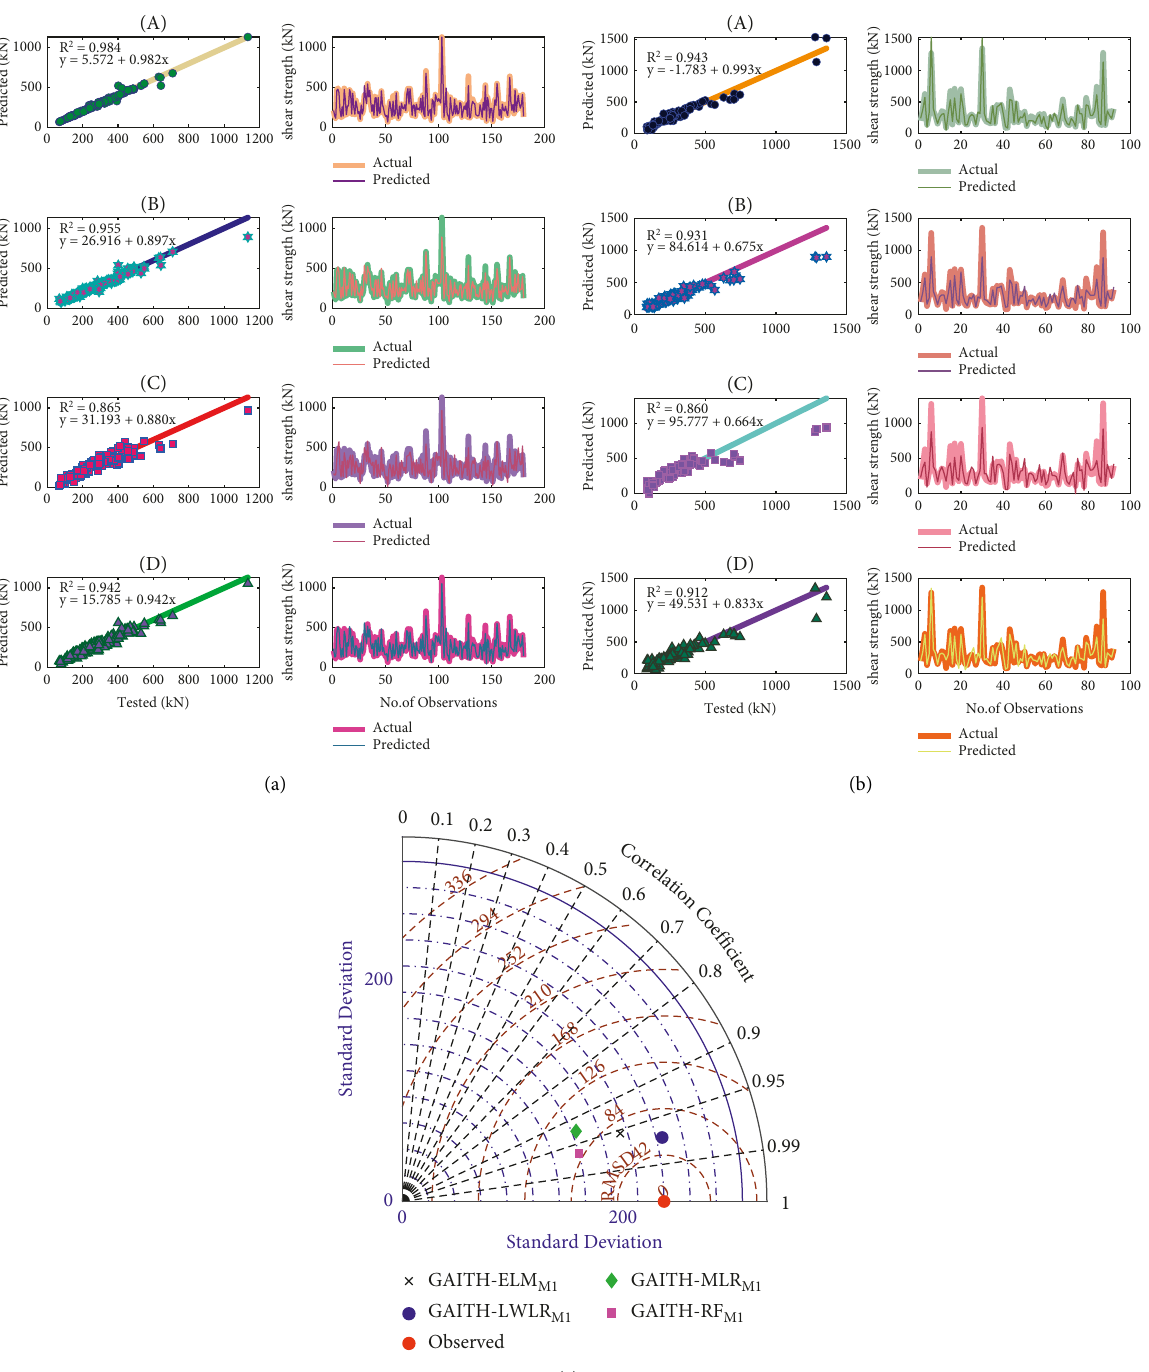
, GAITH − RF , GAITH − M 1 M 1